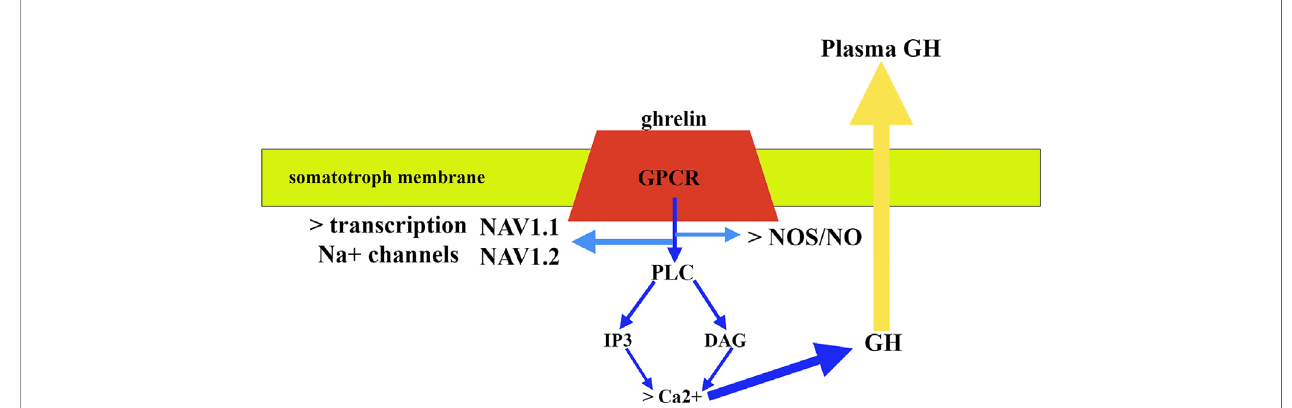
FIGURE 5 | Mechanism of action of ghrelin in pituitary somatotrophs. After binding to a G-protein-coupled receptor (GPR) and activating it, the signaling pathways involve stimulation of phospholipase C (PLC) activity. This activation leads to the formation of inositol 1,4,5 triphosphate (IP3) and diacylglycerol (DAG) (blue arrows). Both IP3 and DAG induce an increase in cytosolic calcium that allows GH release (yellow arrow), although activation of NOS/NO pathway is also required. In addition, the effect of ghrelin includes the activation of the transcription of the Na+ channel gene that leads to the expression of two isoforms of Na+: NAV1.1 and